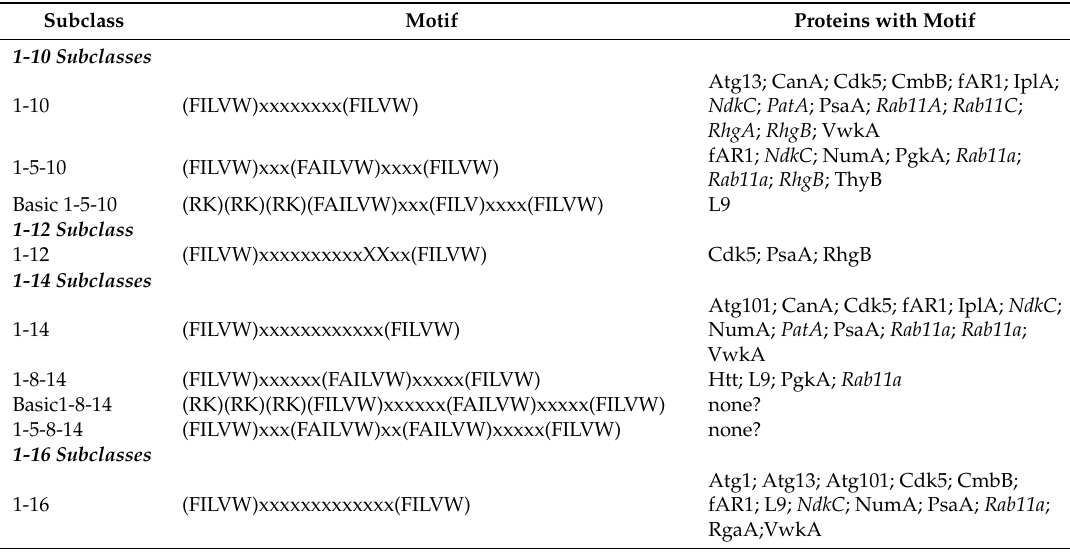
Table 2. Calcium-dependent Calmodulin Binding